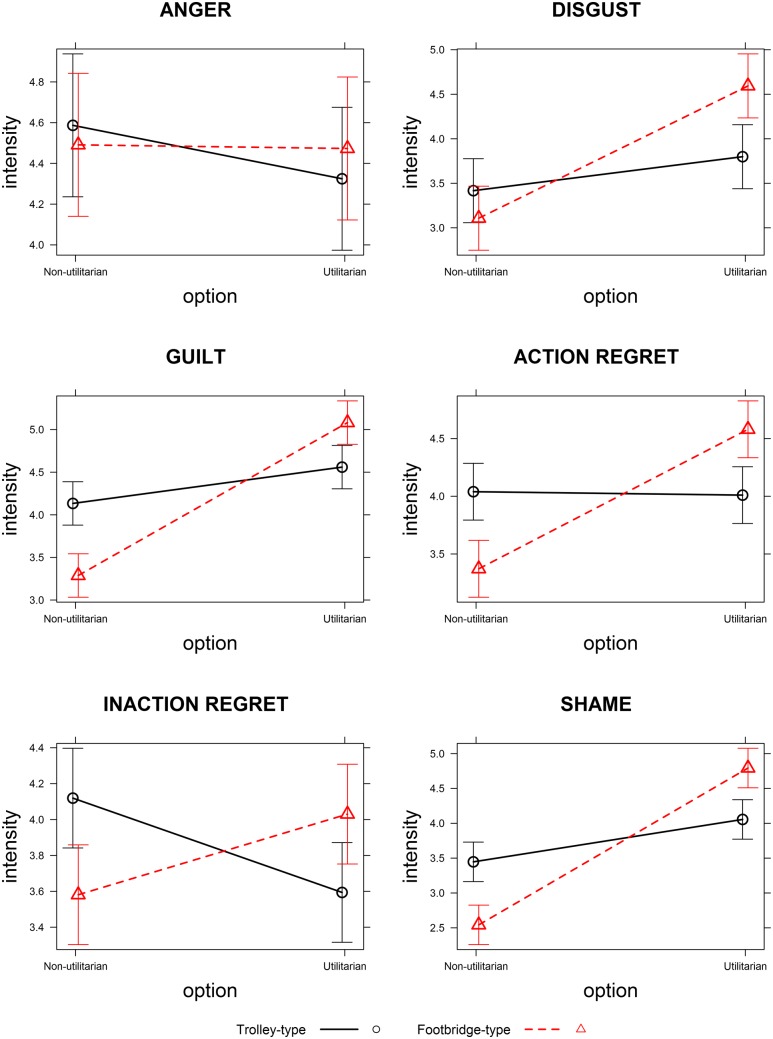
Effects of Dilemma Type on emotional intensities as a function of Option. The scales ranged from 0 (no intensity) to 6 (maximal intensity). Error bars indicate 95% confidence intervals.